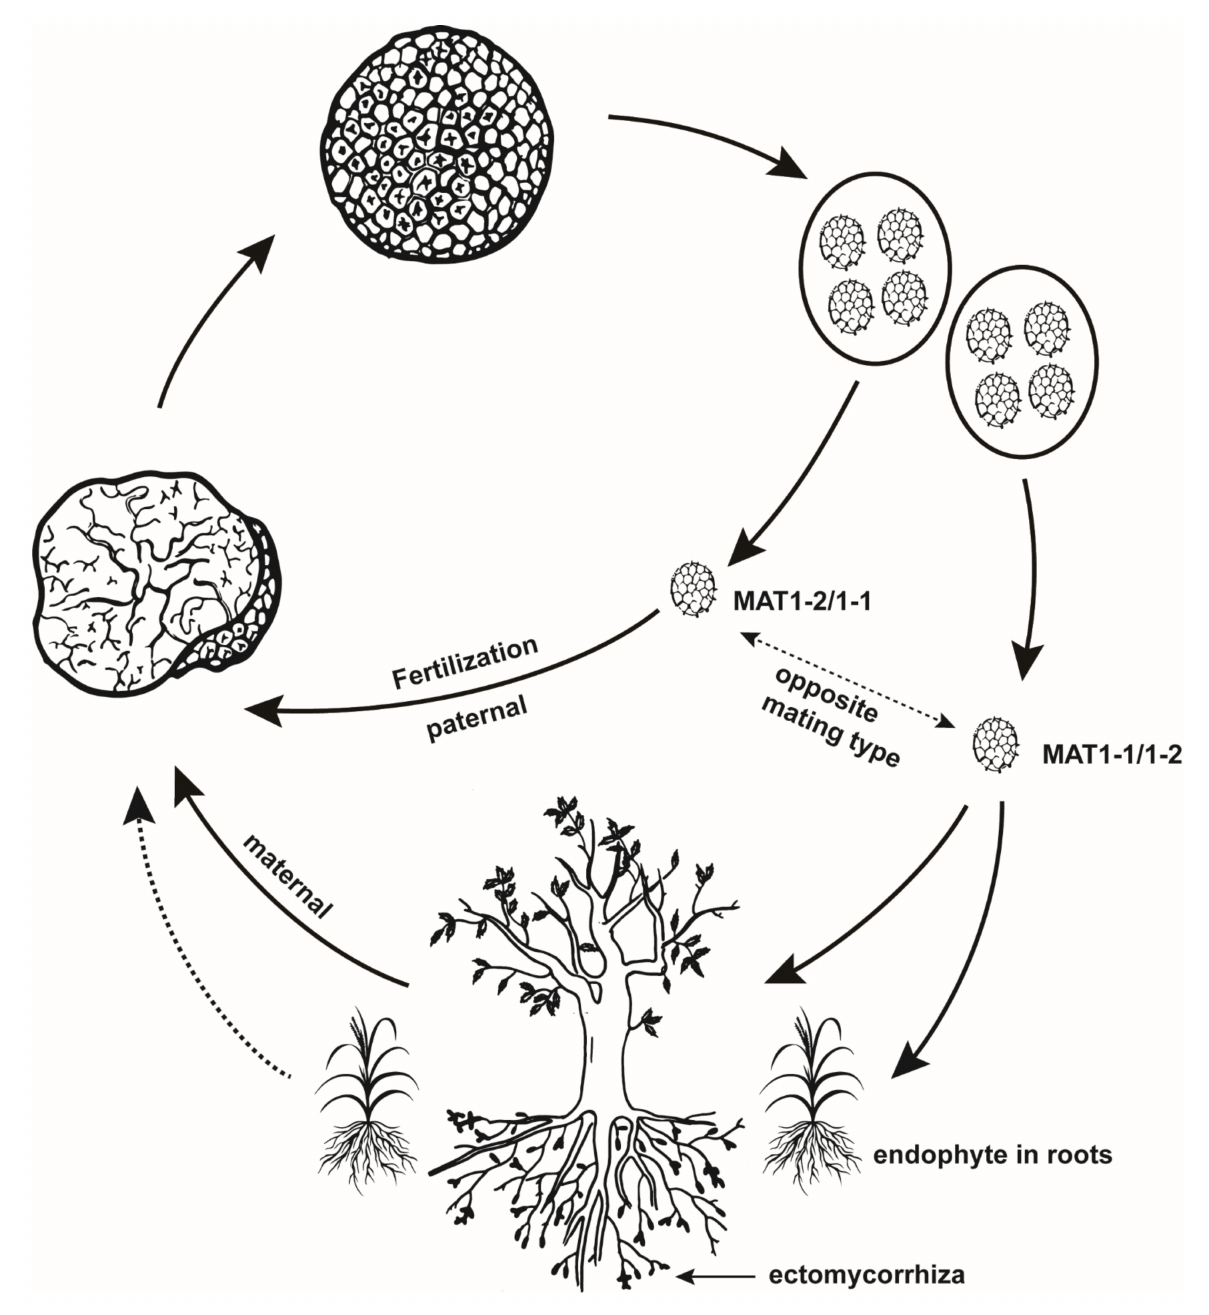
Figure 1. A scheme showing the life cycle of true